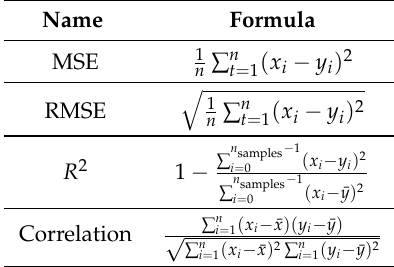
Table 3. Evaluation metrics for monthly rainfall prediction.